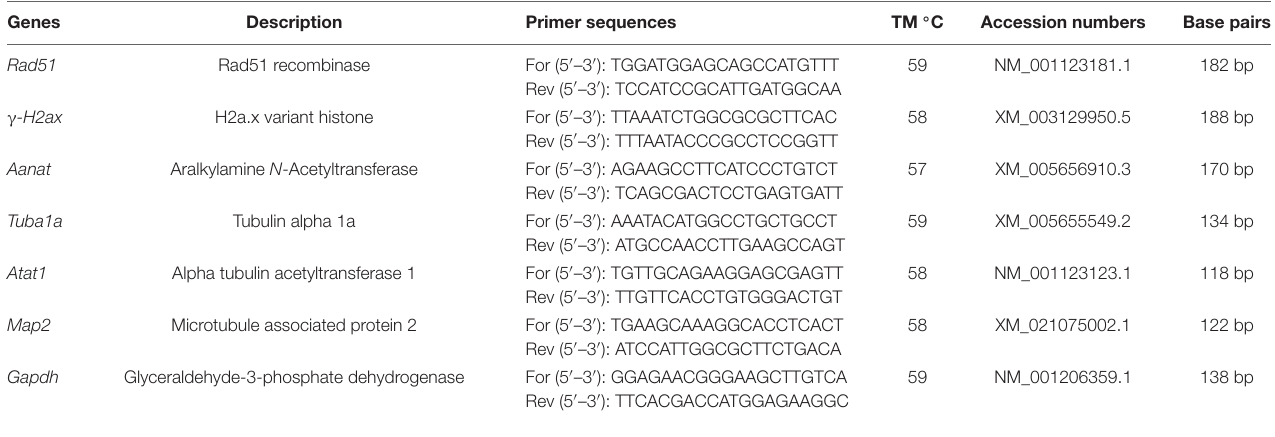
TABLE 1 | Primer sequences and real-time PCR conditions in mature